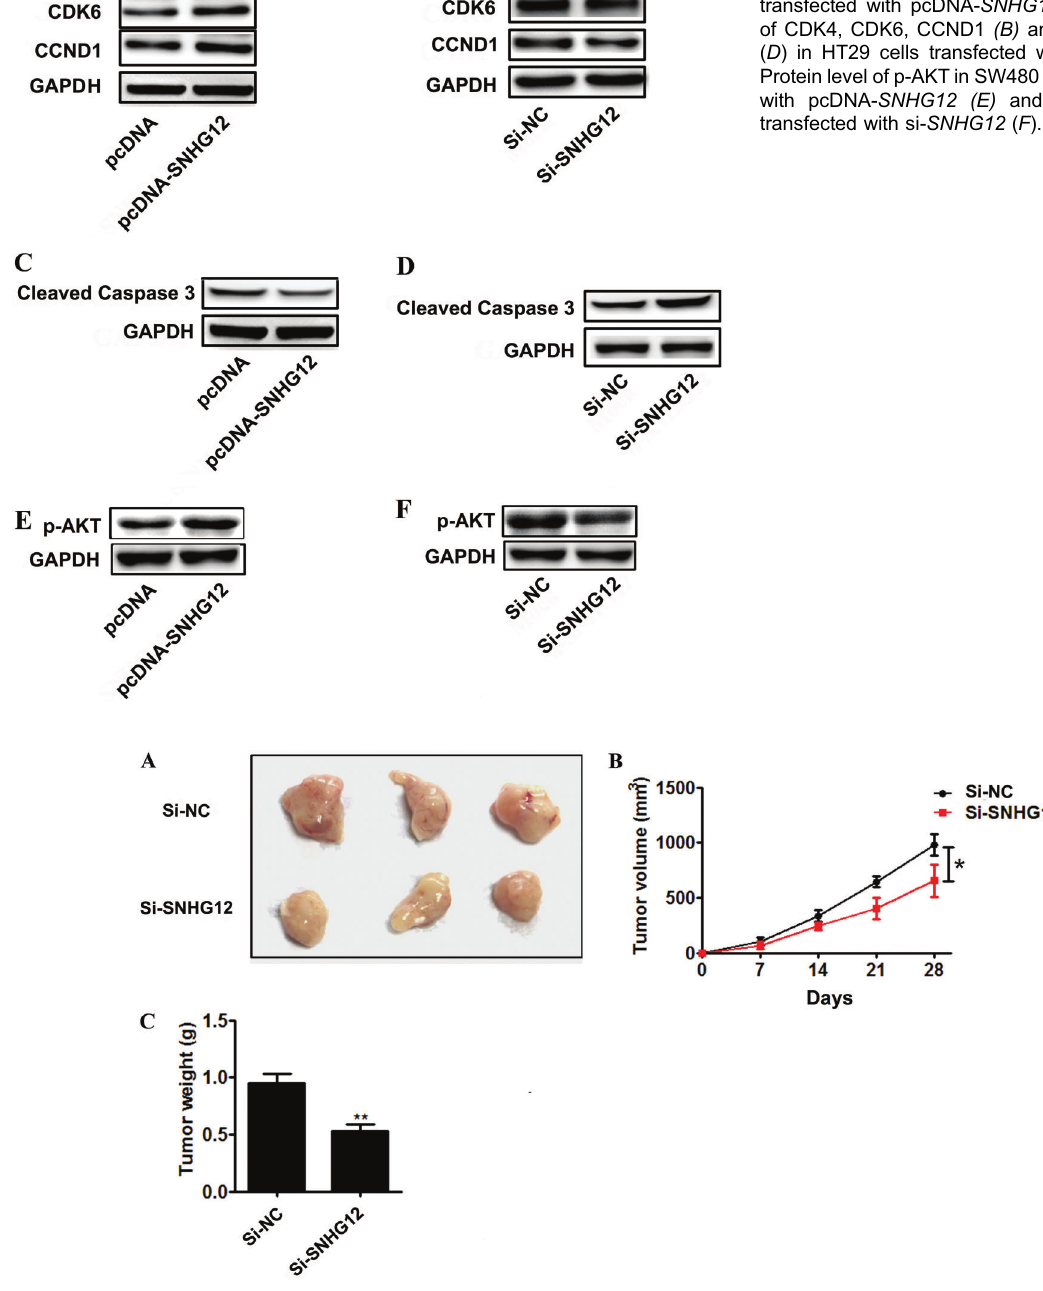
Figure 6. Protein level of CDK4, CDK6, CCND1 ( A) and of caspase 3 ( C ) in SW480 cells transfected with pcDNA- SNHG12 . Protein level of CDK4, CDK6, CCND1 (B) and of caspase 3 ( D ) in HT29 cells transfected with si- SNHG12 . Protein level of p-AKT in SW480 cells transfected with pcDNA- SNHG12 (E) and in HT29 cells transfected with si- SNHG12 ( F ).